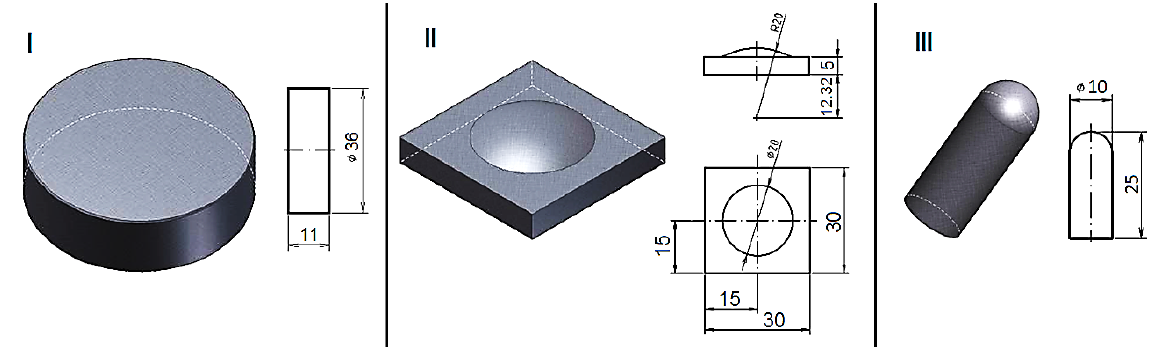
Figure 2: Studied sample surfaces; (i) flat sample with planar surface, (ii) flat sample with parabolic surface, (iii) rotary sample with hemi- spherical surface.